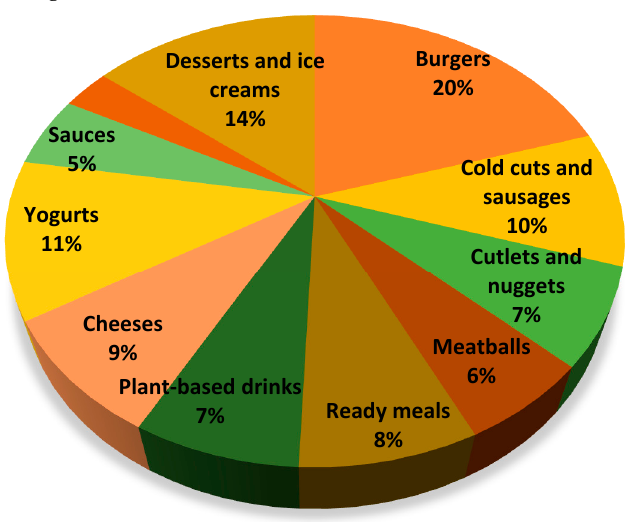
Figure 1. Prevalence of processed plant-based products categories examined in this study. The graph reported the percentage of samples in each categories considering a total number of 560 analyzed products.